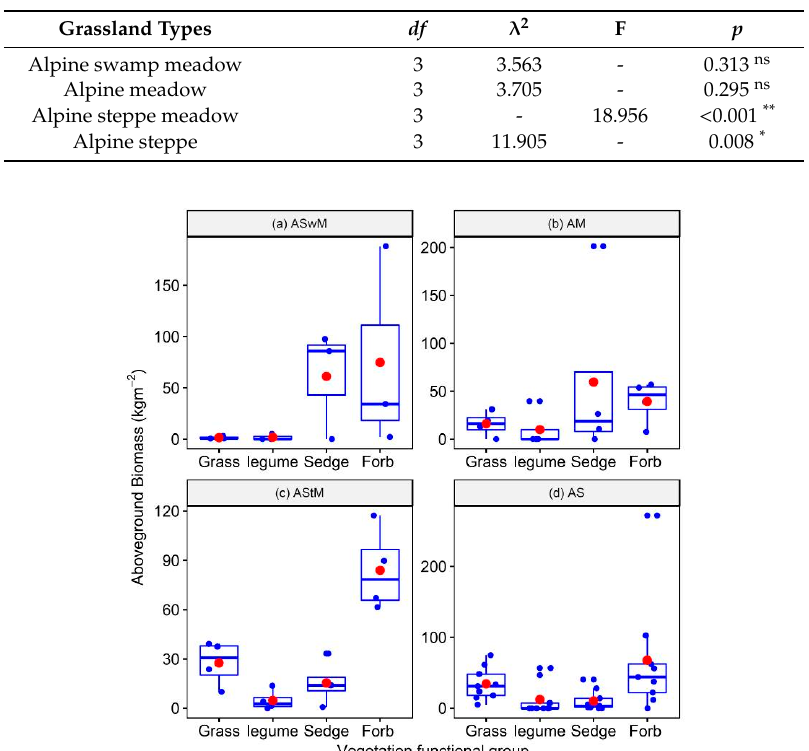
Figure 9. Vegetation biomass of four functional groups in ( a ) alpine swamp meadow (ASwM), ( b ) alpine meadow (AM), ( c ) alpine steppe meadow (AStM) and ( d ) alpine steppe. Red dots represent mean value of different types of functional groups. Blue dots represent the value of all sampling sites (n = 21). The bold solid horizontal line means the median value. Grass is monocotyledon, which is characterized by an alternate leaf, stem section and caryopsis. Legume, belonging to the family of Rosalesis, is dicotyledon, which can fix nitrogen by symbiotic rhizobia. Sedge is also a monocotyledon with a solid stem, leaf sheath and small flower clustered into a spikelet. Forb is the general name of all herbage plants other than grass, legume and sedge.